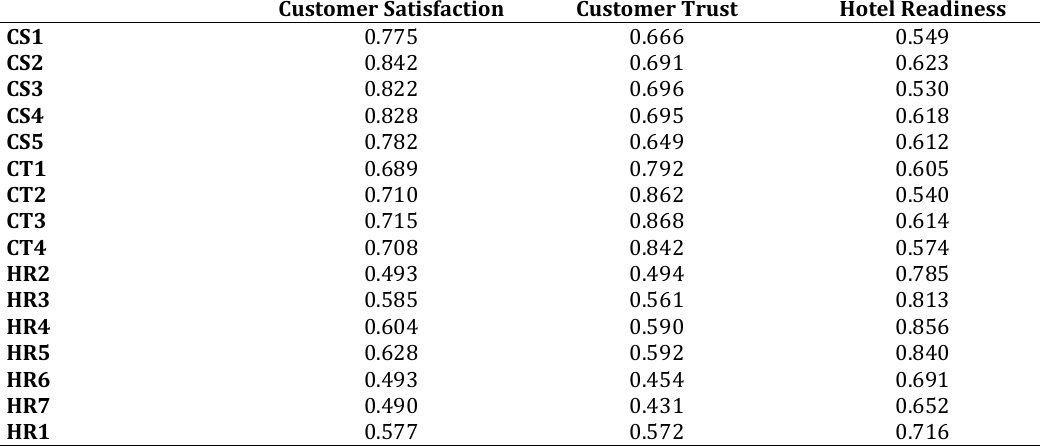
Table 8: Cross loading for international hotel chain Customer Satisfaction Customer